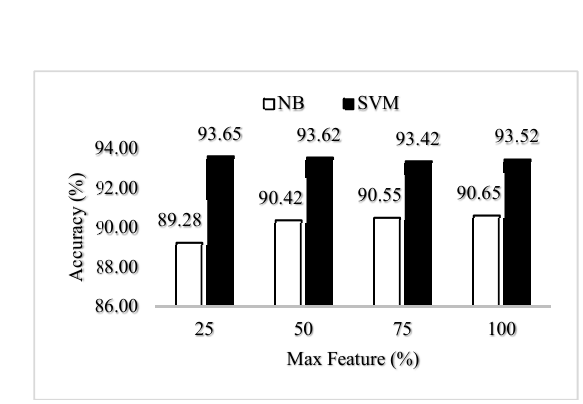
Figure 3. Accuracy